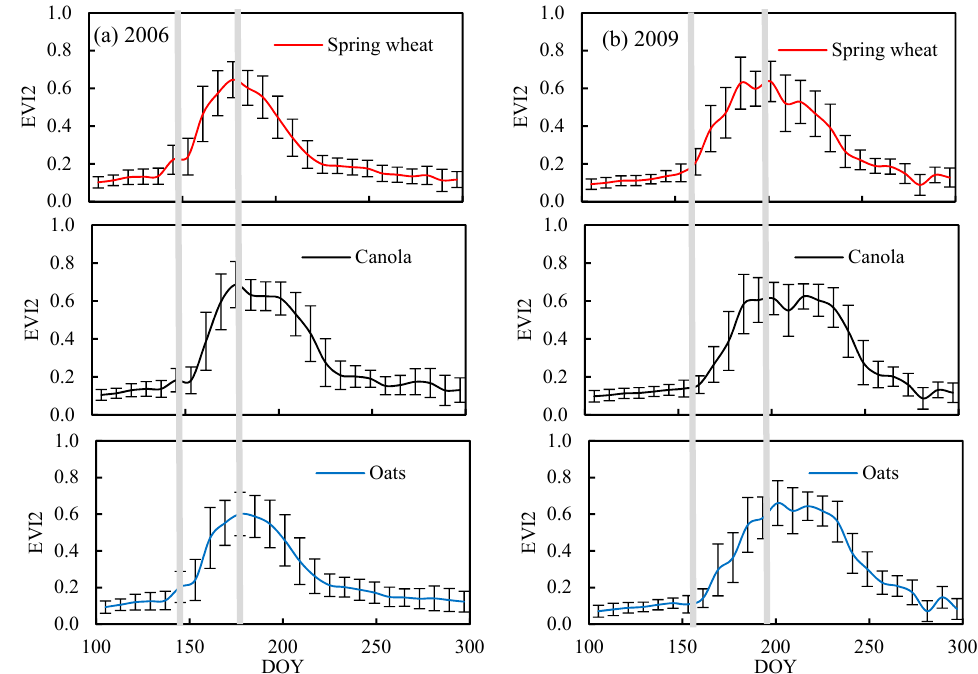
Figure 9. Time-series EVI2 for the three crops (spring wheat, canola and oats) in two different years (2006 (a) and 2009 (b)). The two grey vertical lines highlight the period of vegetative stage.